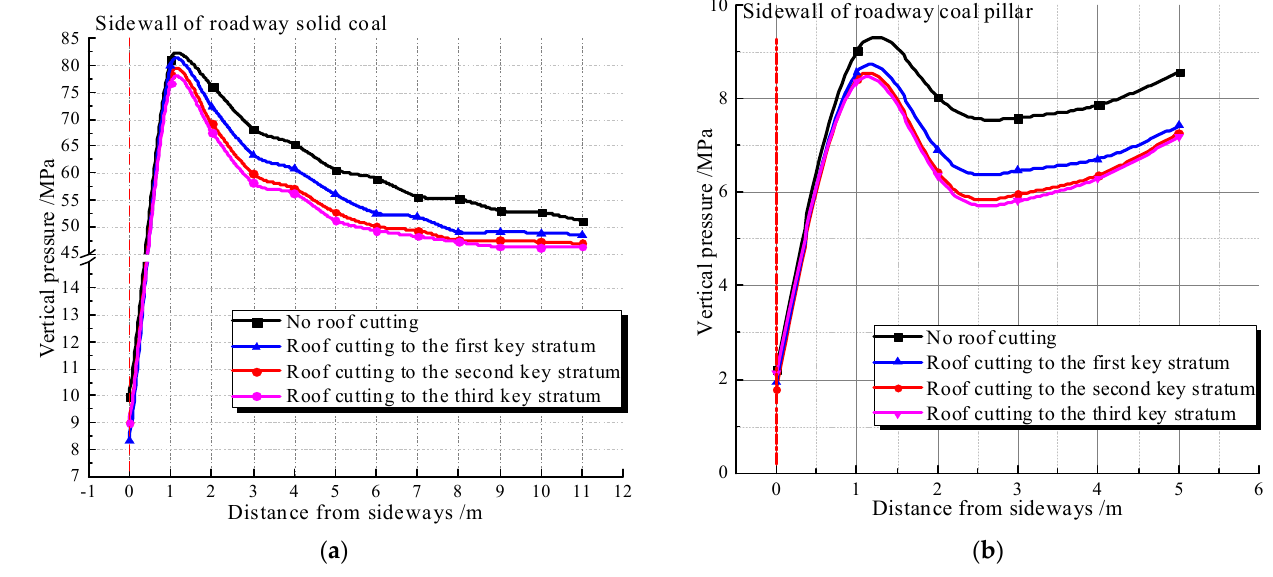
Figure 8. The effect of different roof cutting heights (stratahorizon) on the surrounding rock stresses of the gob-side entry; ( a ) Vertical stress at solid coal side of roadway; ( b ) Vertical stress at coal pillar side of roadway.